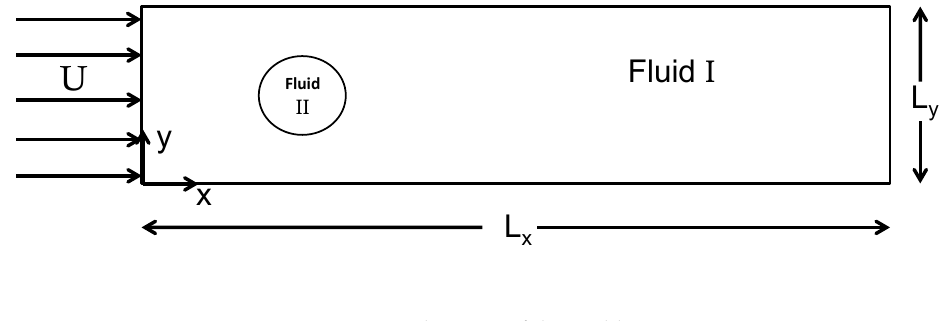
Figure 1. Schematic of the